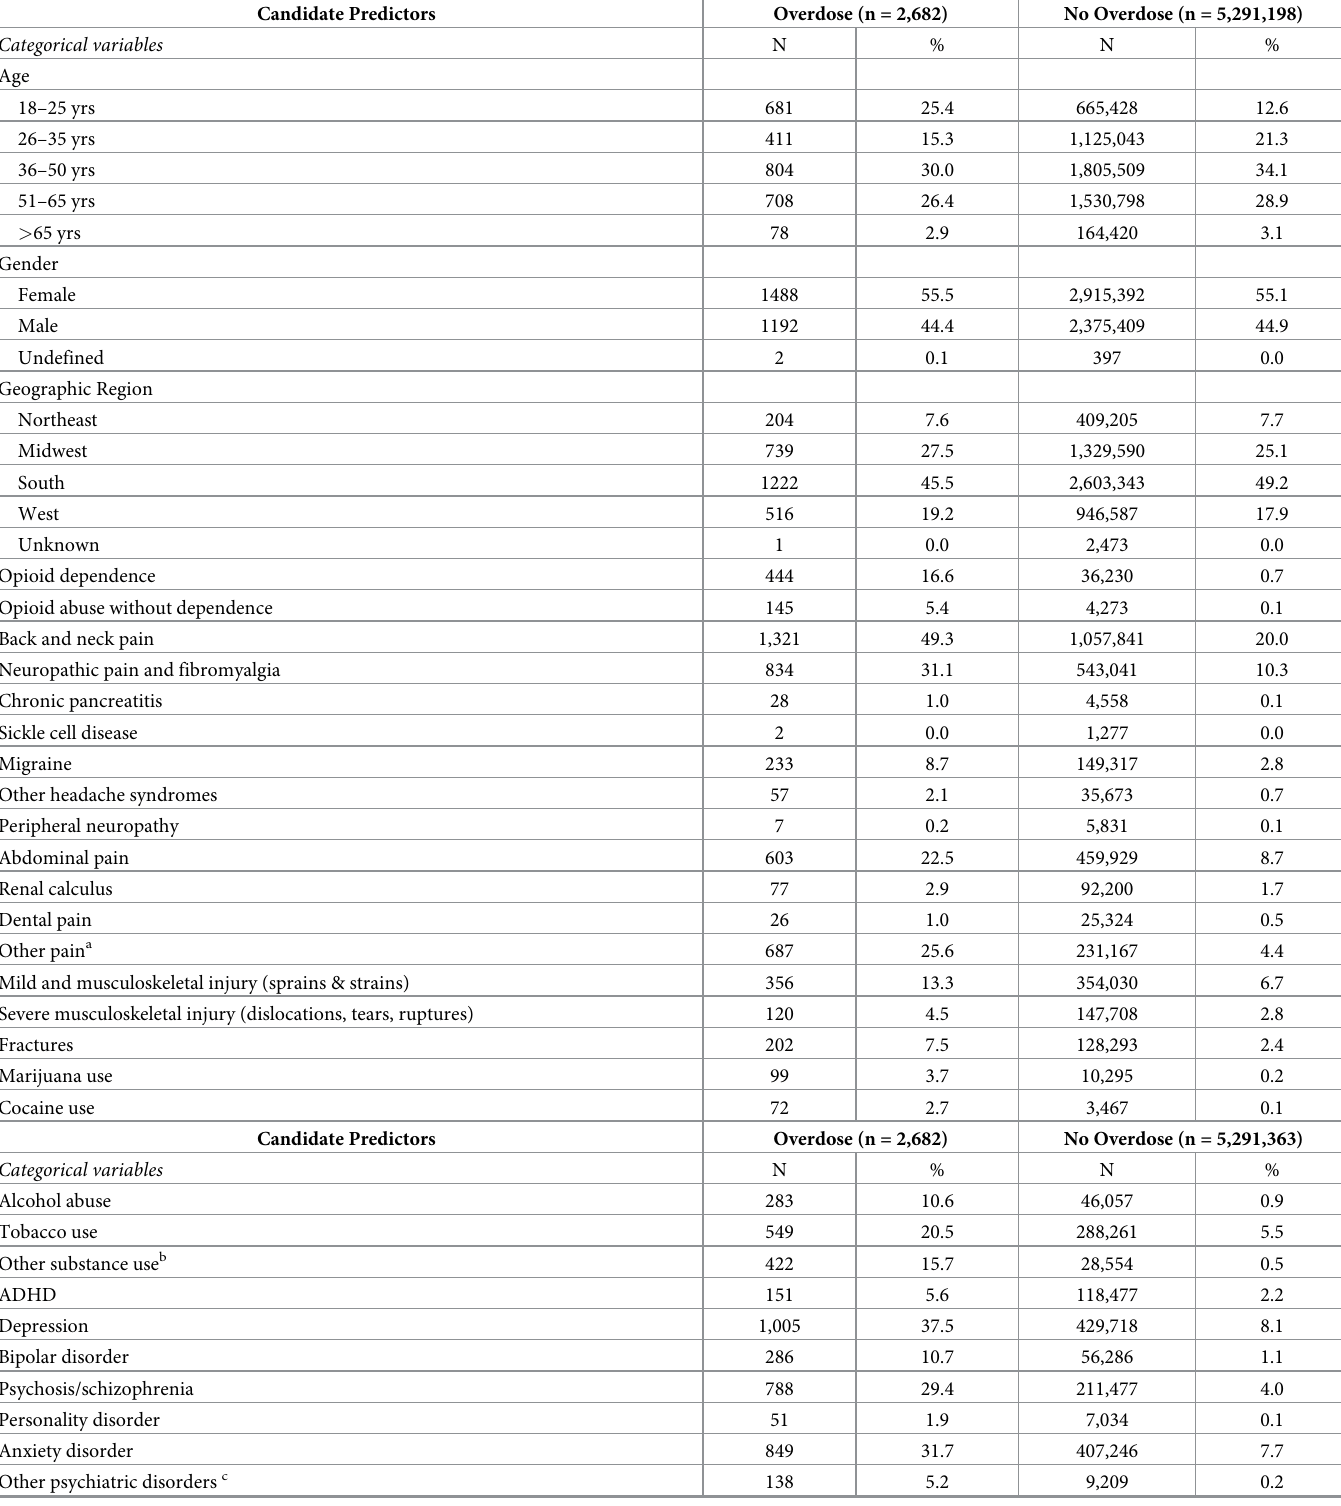
Table 1. Characteristics during the window prior to censoring for patients who have filled at least 1 opioid prescription between October 2011 to September